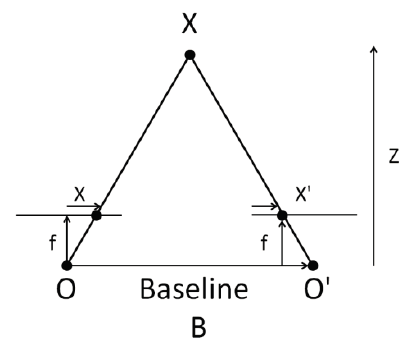
Figure 4. Pin hole camera model.